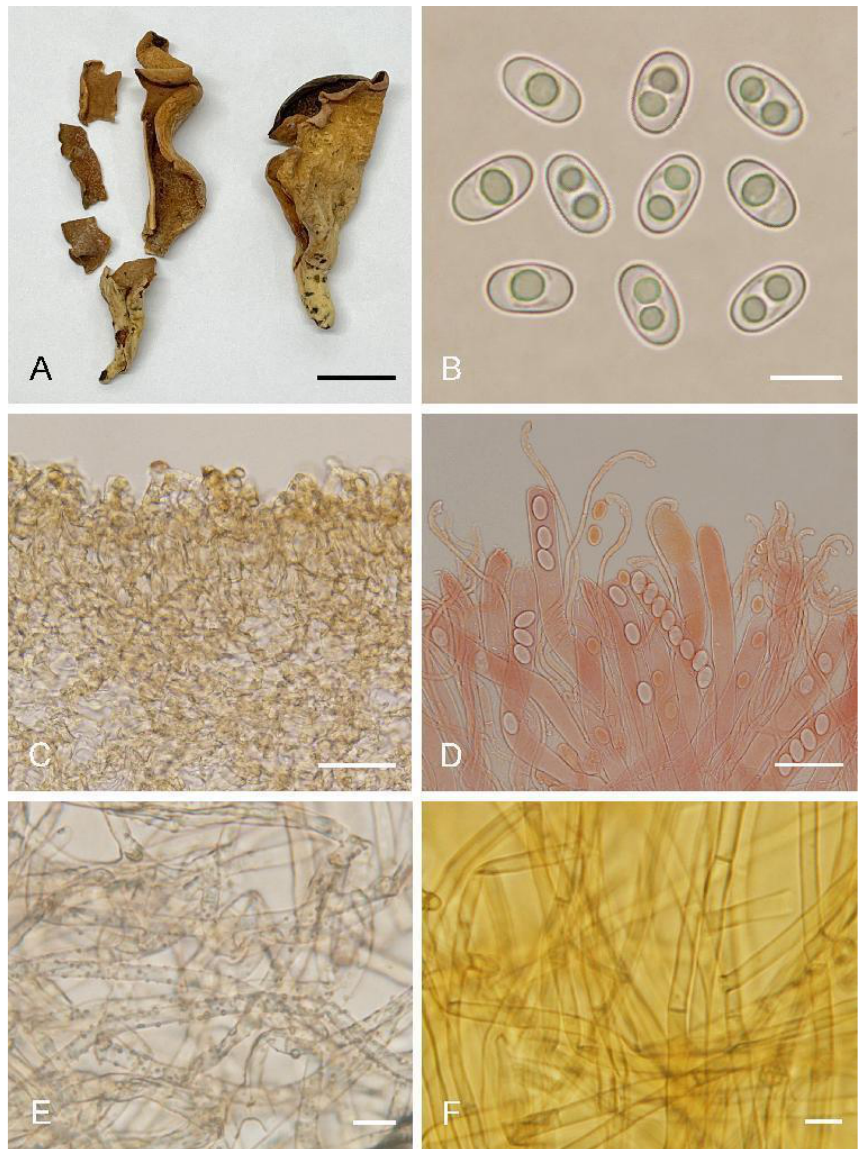
Figure 5. Otidea gongnaisiensis (HMAS 69951) ( A ) apothecia, ( B ) ascospores, ( C ) ectal and medullary excipulum in KOH, ( D ) asci and paraphyses in Congo Red, ( E ) basal mycelium in water, and ( F ) basal mycelium in MLZ. Scale bars: ( A ) = 1 cm, ( B , E , F ) = 10 μm , ( C ) = 50 μm , ( D ) = 3 0 μm . Otidea hanzhongensis L. Fan, M.Q. Zhu & Y.Y. Xu, sp. nov. (Figure